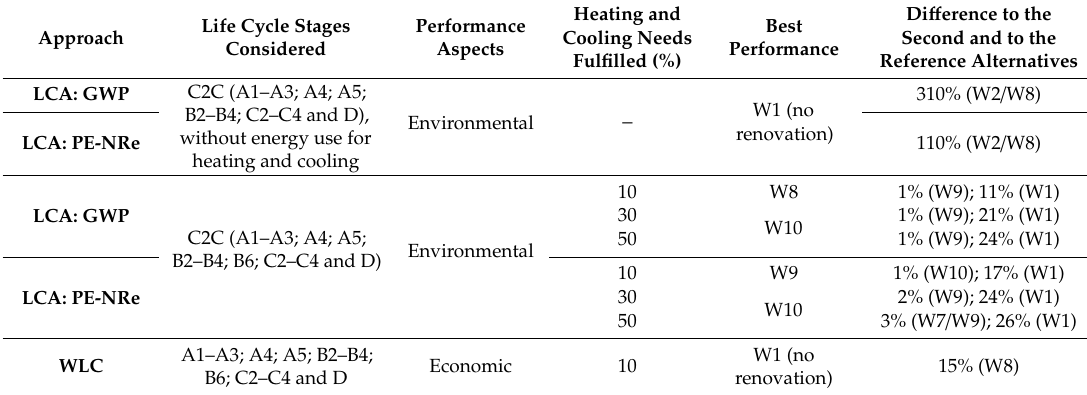
dimension analysed.